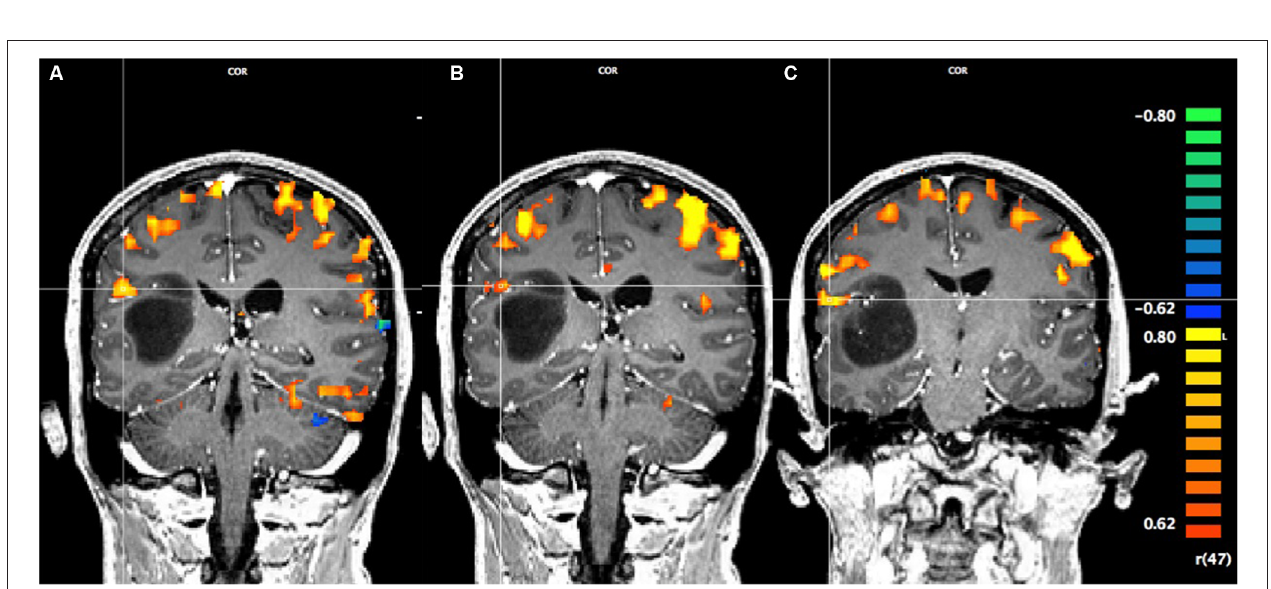
FIGURE 1 | Pre-operative functional magnetic resonance imaging (fMRI) for the three motor-sensory tasks. The position of the cross-hairs illustrates the activation of interest nearest to the astrocytoma in each task. (A) Activation in the arms rubbing on scanner task. (B) Activation in the hands rubbing on scanner task. (C) Activation in the lip-licking task.